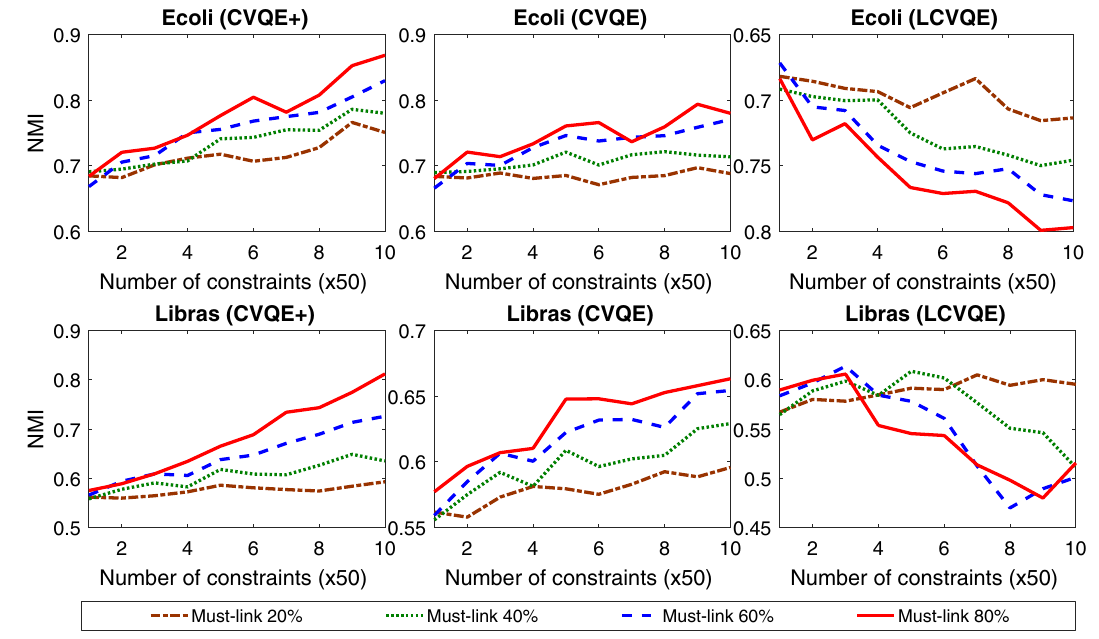
Fig. 7 Effect of constraint types on CVQE+ (left), CVQE (middle) and LCVQE (right) for the Ecoli and Libras